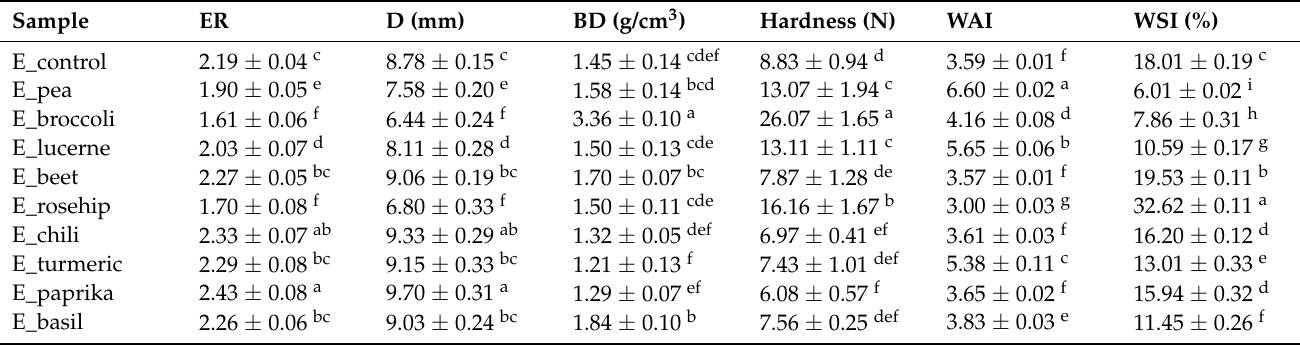
Table 2. Physical properties of the different types of corn-based